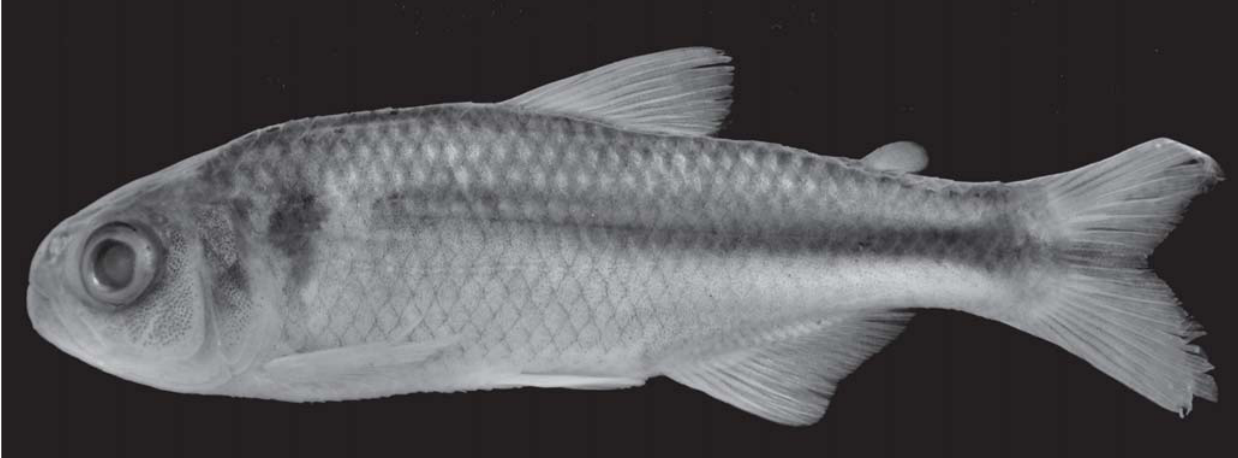
Fig. 2. Astyanax microschemos , MCP 37569, holotype, 55.1 mm SL; córrego Palmital, rio Itapemirim drainage, Iúna, Espírito Santo, Brazil.